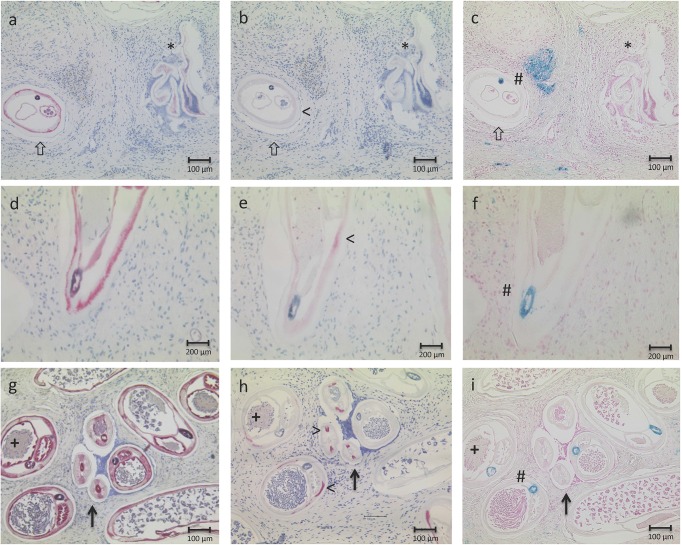
Histological analysis of endobacteria content and worm age.Worms were categorized using three different staining methods, i.e. APR (a, d, g), anti-Diwsp or wBmPAL (b, e, h) and iron staining (c, f, i). Worms were alive at the time of nodulectomy (a, d, g), when they stained positive for APR in the hypodermis, embryos, gut and uteri, whereas dead worms were APR-negative (a, *). Wolbachia levels were categorized as negative (b, <), few (e, <) or many (h, <). In addition, age of the worms was estimated as described previously and included a combination of size, general organ and tissue structure (a, b, d, e, g, h) as well as iron deposition in the gut (#, c, f, i). Worms shown here were classified as old (> a-c), middle aged (d, e, f), young (+, >, g, h, i).